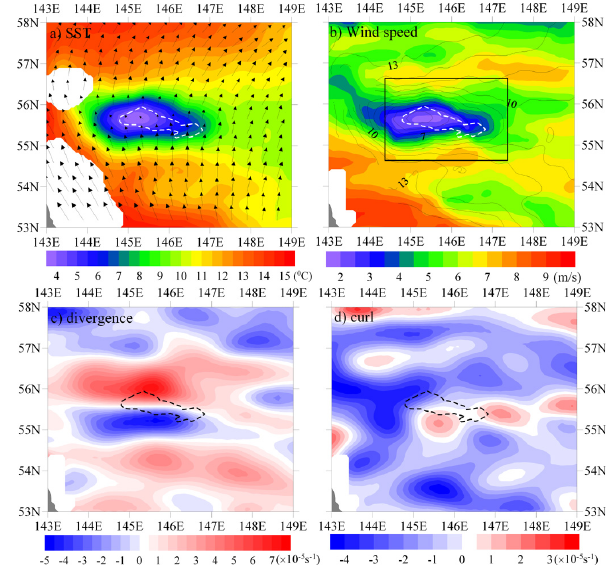
Fig. 2. Unfiltered fields of (a) AMSR-E SST with QuikSCAT wind vector, (b) QuikSCAT wind speed with isotherms, divergence (c) and curl (d) wind from descending satellite pass on 29 July 2006. The wind curl and divergence were calculated across the wind field, smoothed with the use of Gaussian filter with bandwidth 50km. A dotted line is isobath